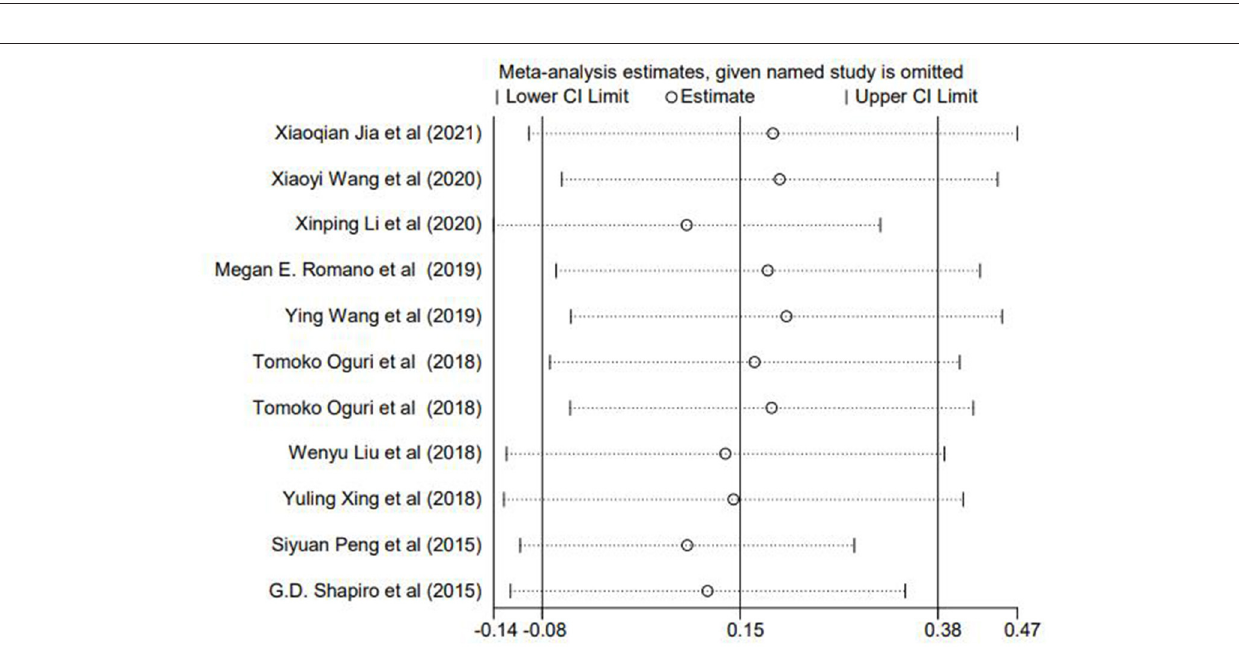
FIGURE 2 | Forest plots of associations between cadmium exposure and the risk of GDM.